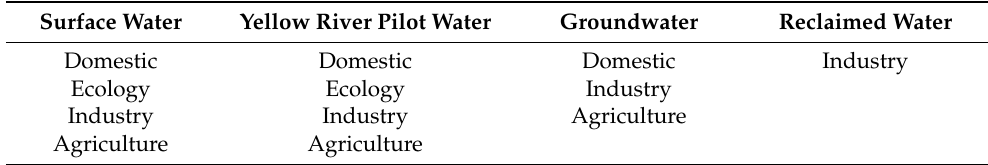
Table 1. Water resource allocation network structure of Binzhou in 2020.